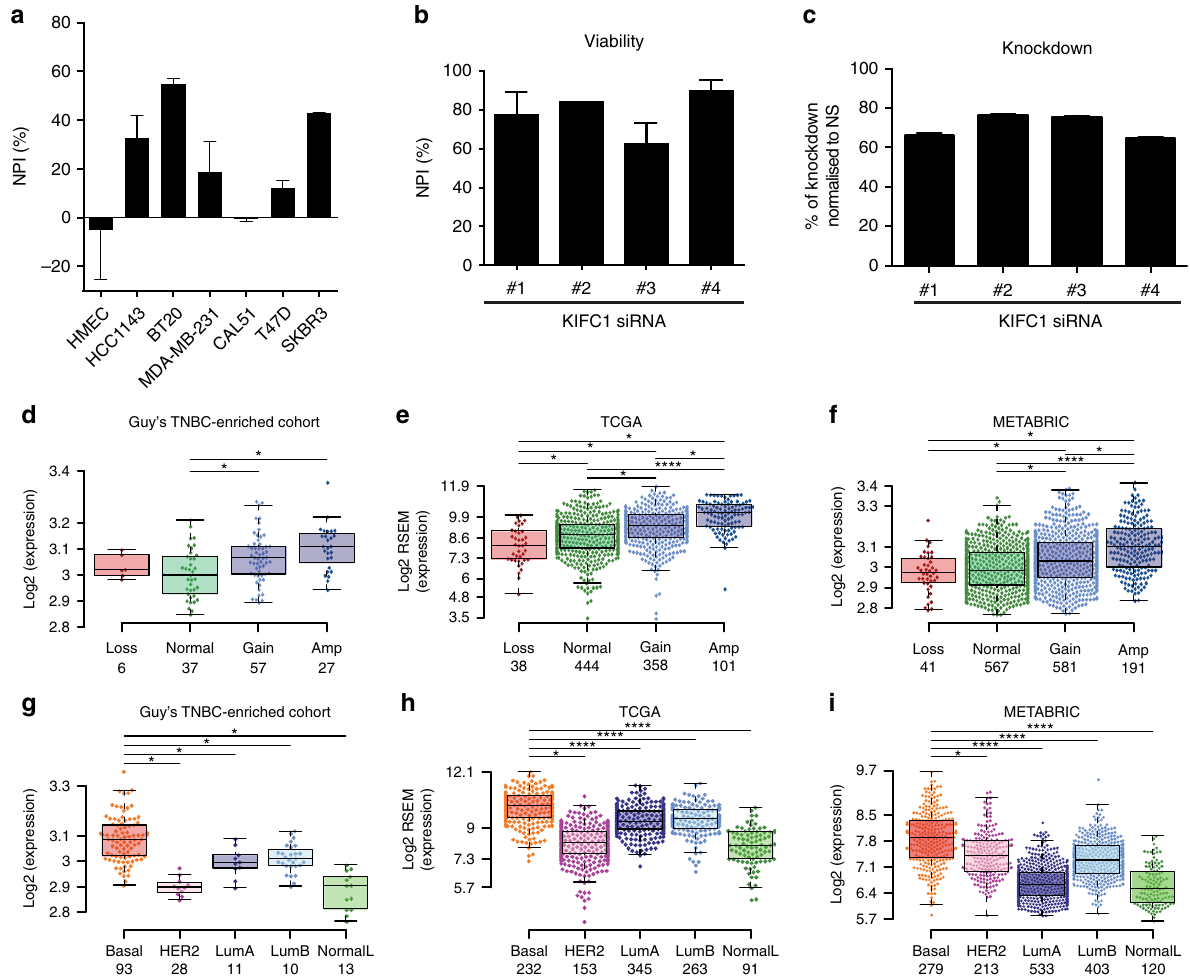
Fig. 3 KIFC1 is a validated tumor addiction gene that is upregulated in TNBCs. a Primary pooled siRNA oligo validation data for KIFC1. Mean NPI are plotted and error bars represent the SEM, n = 3. b Mean NPI from three independent of HCC1143 cell line after deconvolution of pool of KIFC1 siRNAs used independently. Error bars represent SEM, n = 3. c mRNA knockdown of individual siRNAs in HCC1143 cells. Knockdown was evaluated by qPCR and represented as percentage of knockdown compared to non-silencing control from three technical replicates. d Copy number alterations of KIFC1 correlated with its gene expression across all breast cancers in the Guy ’ s TNBC-enriched cohort of breast cancers, ( e ) TCGA BRCA and ( f ) METABRIC data sets. g KIFC1 gene expression across the PAM50 breast cancer subtypes in the Guy ’ s TNBC-enriched cohort of breast cancers, ( h ) TCGA BRCA and ( i ) METABRIC data sets. Box-and-whisker plots showing median center line, 25% and 75% box limits and range of expression, non-paired two-sided Wilcoxon rank sum test; * p < 0.05, **** p